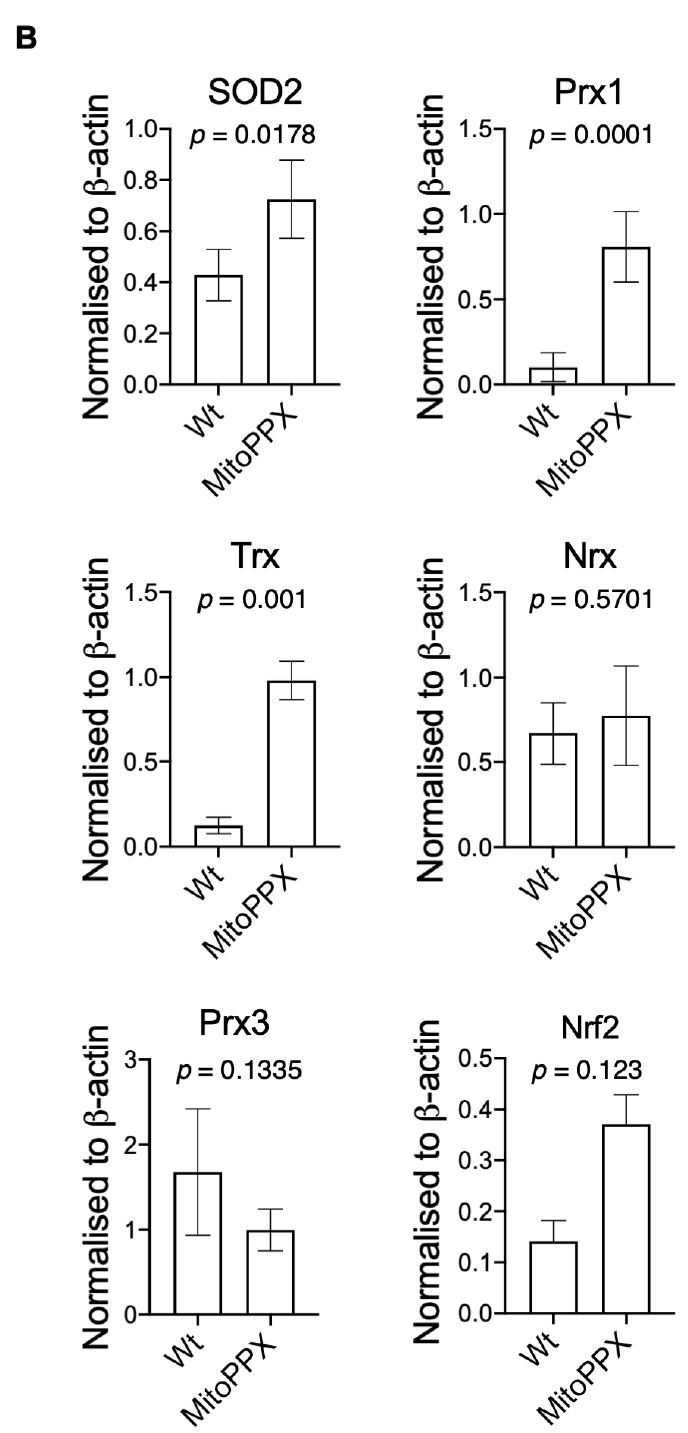
Figure 3. Antioxidant levels are increased in MitoPPX cells. ( A ) Non-reducing immunoblotting was performed to detect the basal levels of SOD2, Prx1, Trx, Nrx, Prx3, and Nrf2 in MitoPPX and Wt cells. Representative membranes are shown. β -actin was used as a loading control. ( B ) Densitometric analysis of basal SOD2, Prx1, Trx, Nrx, Prx3, and Nrf2 protein levels. Data shown as mean ± standard deviation from three independent experiments are presented. Unpaired t-tests were used to detect significant differences between Wt and MitoPPX cells. Abbreviations used in this figure : SOD: superoxide dismutase 2; Prx1: peroxiredoxine1; Trx: thioredoxin; Nrx: nucleoredoxin; Prx3: peroxiredoxine 3; Nrf2: nuclear factor erythroid 2-related factor 2; MitoPPX: cells expressing the exopolyphosphatase enzyme on mitochondria; Wt: Wild-type